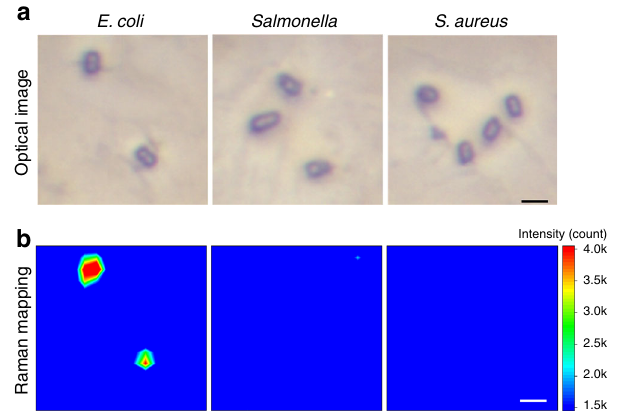
Fig. 7 Detection of a single copy of bacteria with dex-WS 2 . a Optical photographs of distinctly spread single bacterium. b Raman mapping of the single bacterium treated with dex-WS 2 based on the Raman scattering peak at 352 cm − 1 , demonstrating that dex-WS 2 nanosheets could selectively detect E. coli at single copy level (scale bar, 2